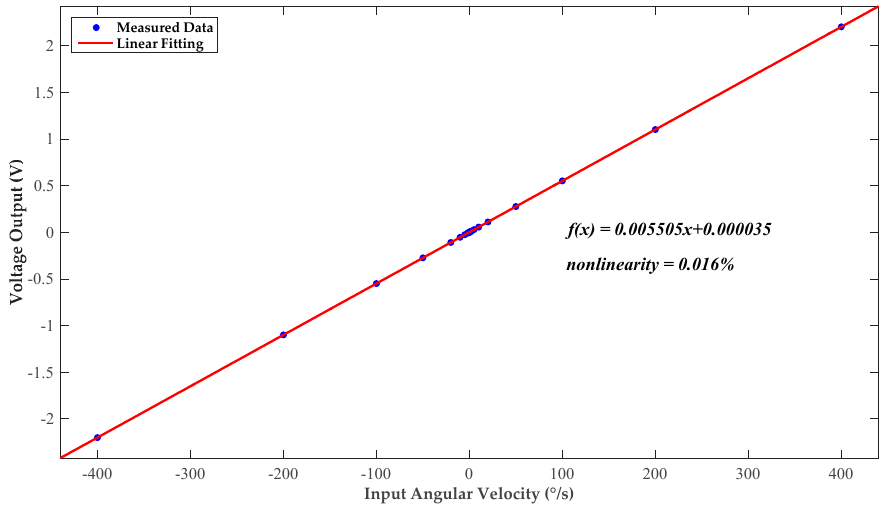
Figure 13. DC transfer function after calibration.